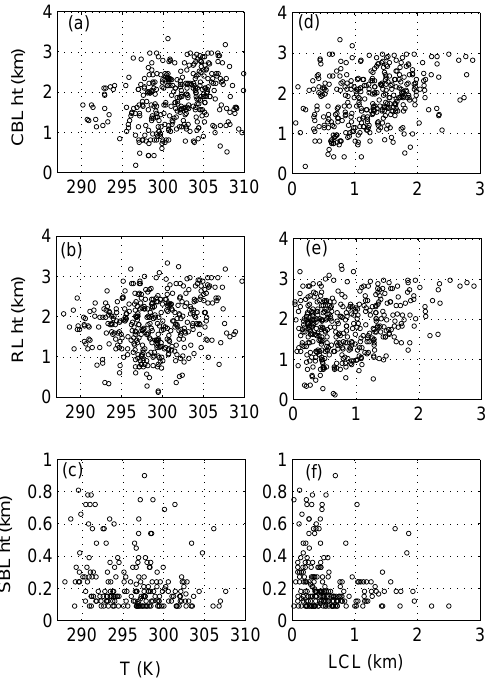
Figure 11. Scatter plot between the surface temperature and (a) CBL, (b) RL, and (c) SBL. (d–f) are the same as (a–c) but for the LCL.